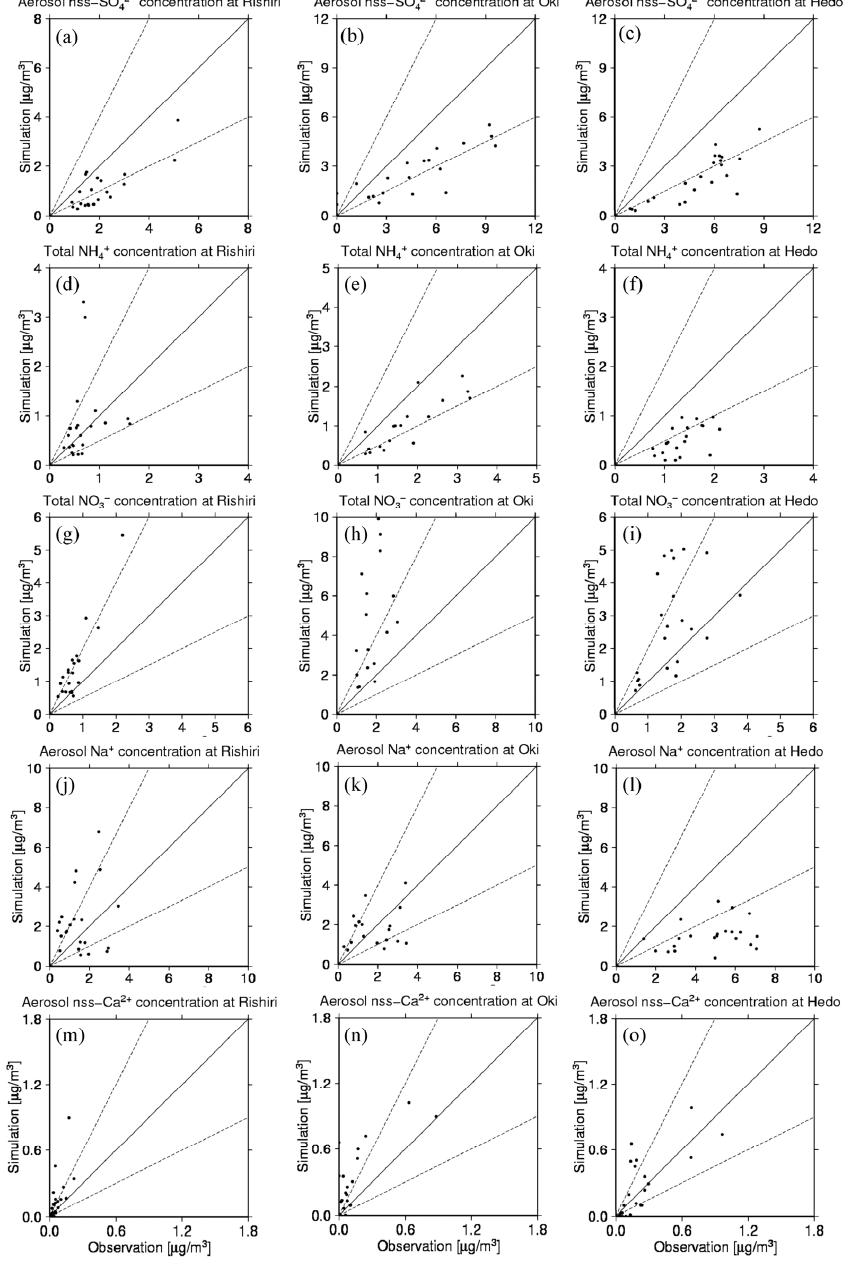
Figure 3. Scatter diagram between observed and modeled concentrations of biweekly (a)-(c) 2 nss-SO 42- , (d)-(f) T-NH 4+ , (g)-(i) T-NO 3- , (j)-(l) Na + , and (m)-(o) nss-Ca 2+ at (left) Rishiri, 3 (center) Oki and (right) Hedo. Solid lines denote the 1:1 line, and dashed lines denote the 4 factor of 2 envelope. 5